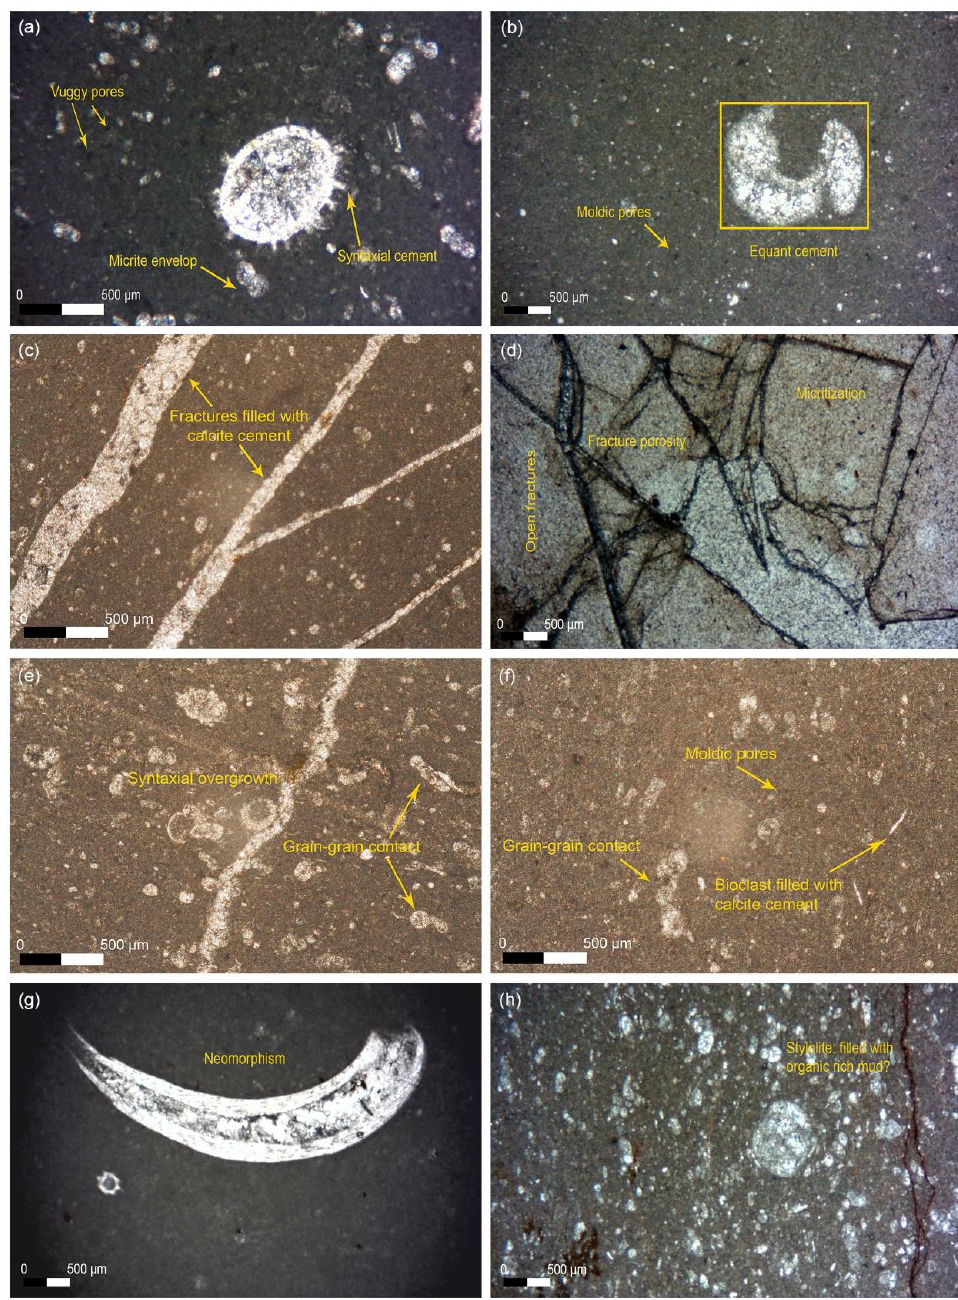
Figure 8. Petrographic analysis showing the different diagenetic processes in carbonate samples collected from Gardiki section (Epirus, Western Greece), ( a ) high micritization, vuggy pores, and syntactical overgrowth cement, ( b ) micritization, Junctions Equant spars of marine moldic pores, ( c ) micritization, late stage of diagenesis-fractured filled with calcite cement, ( d ) early stage of micrite envelop, late stage of open fracture, ( e ) epitaxial overgrowth cement, moldic pores, ( f ) moldic pores, grain-grain contact (physical compaction), ( g ) coarse pale brown neomorphic spar replacement of aragonite shell, ( h ) and stylolites filled with organic-rich